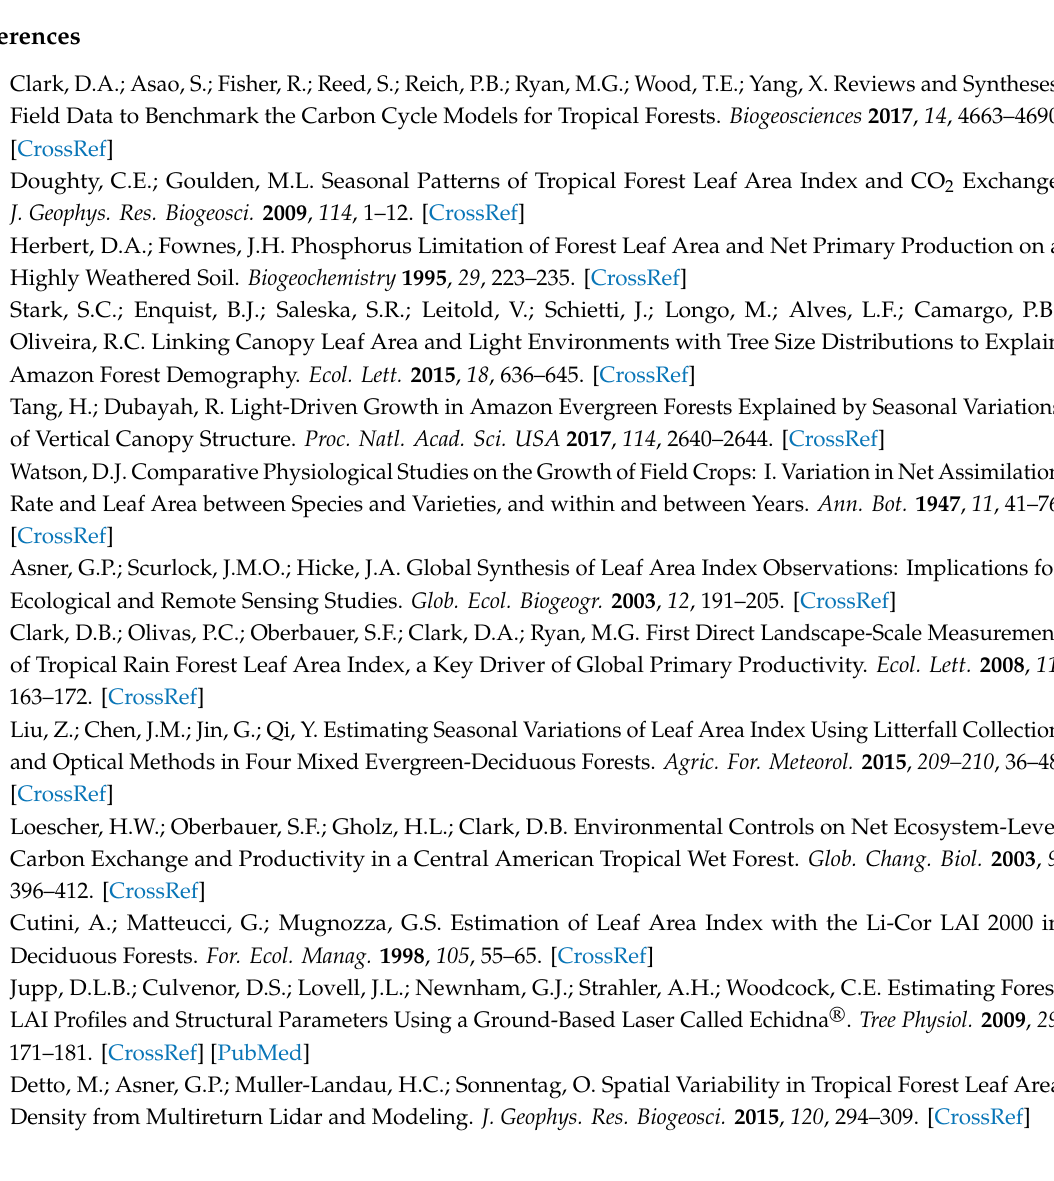
Figure S1: Pixel classification example, Figure S2: Image method correlations, File S1: PAI e ff estimate